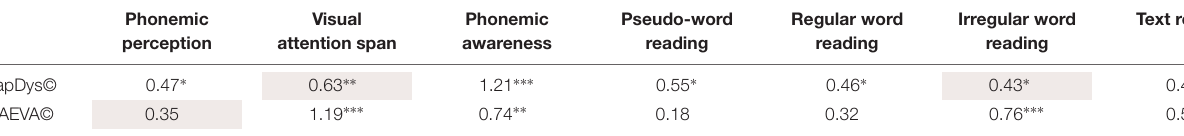
TABLE 3 | Summary of the effect sizes (Cohen’s d ; ∗∗∗ p < 0.001; ∗∗ p < 0.01; ∗ p <